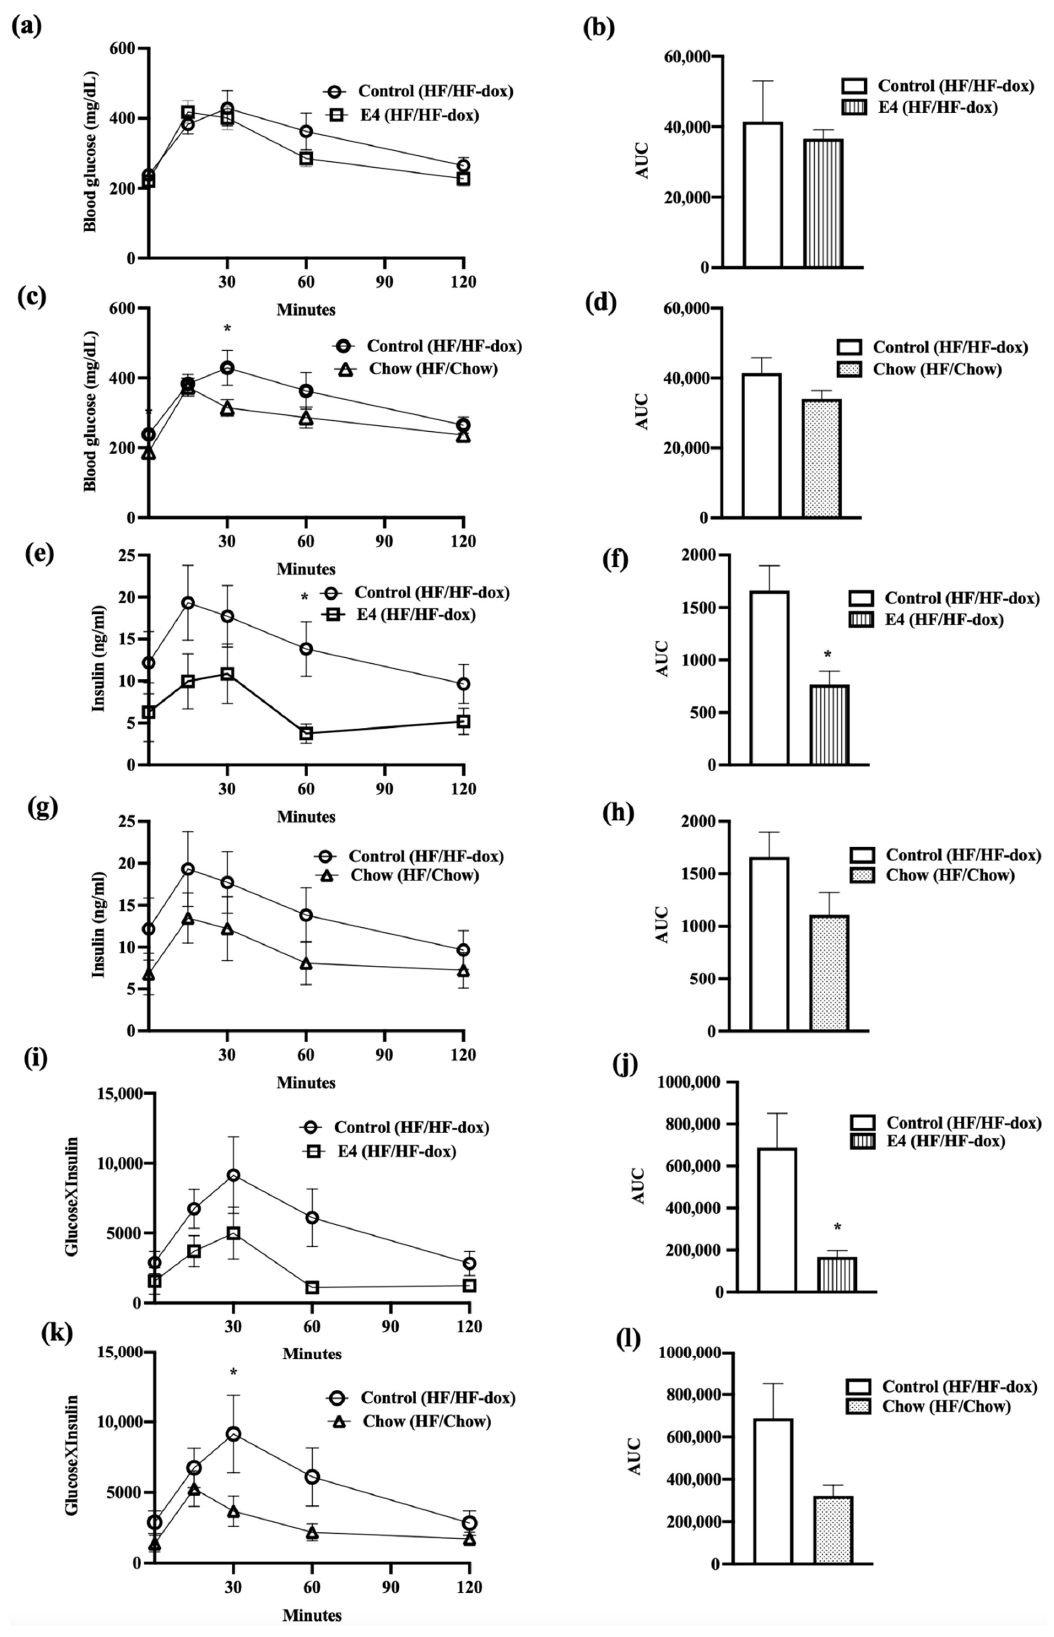
Figure 2. Changes in glycemic control and subsequent insulin requirement during glucose tolerance test (GTT). ( a , b ) represents glucose clearance and corresponding AUC in control and E4. ( c , d )